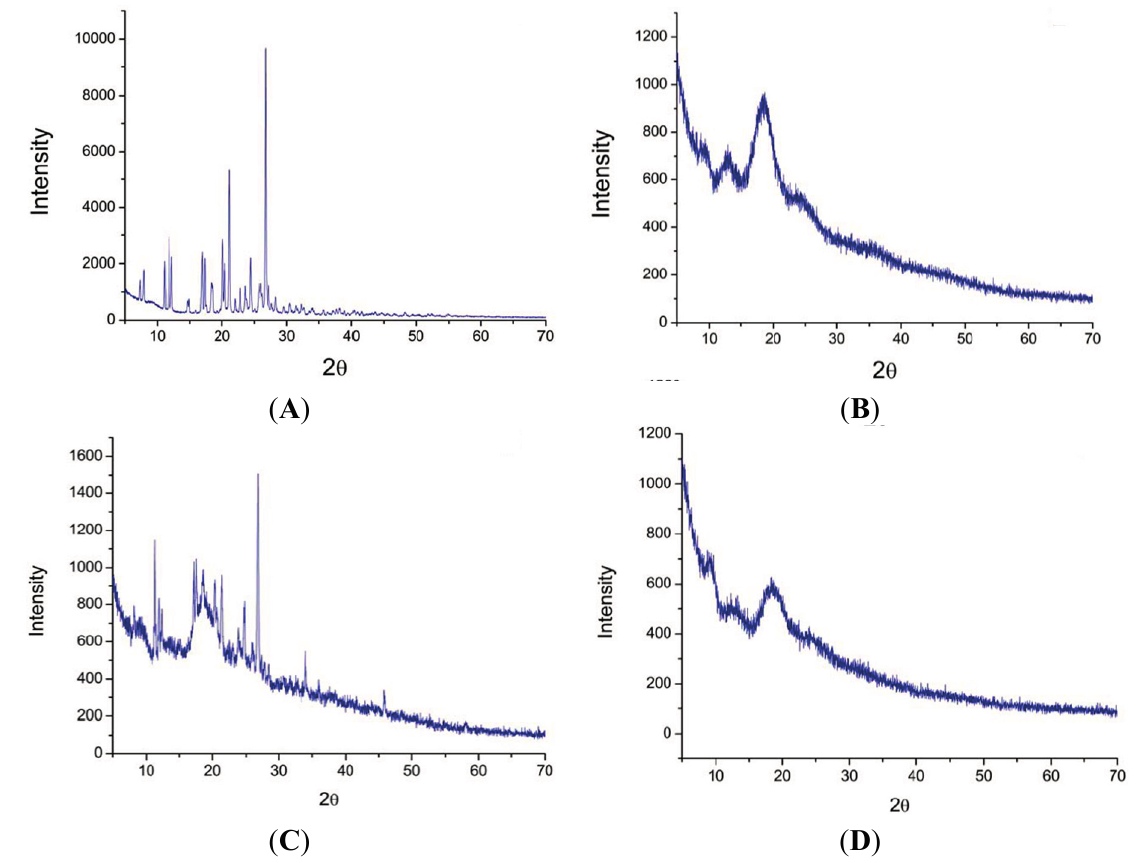
Figure 6. XRD patterns of ( A ) ILTG, ( B ) G2- β -CD, ( C ) the ILTG/G2- β -CD physical mixture, and ( D ) the ILTG/G2- β -CD inclusion